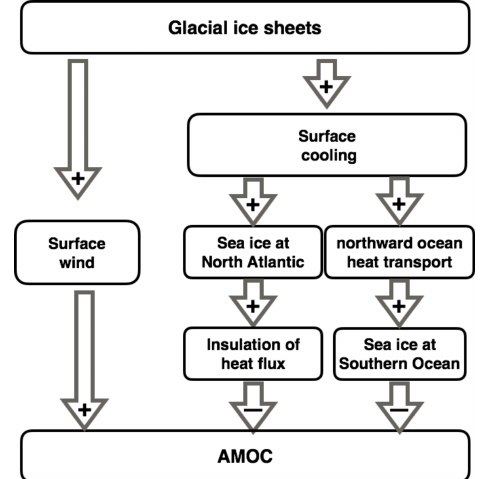
Figure 12. Simple schematic of the processes by which changes in the glacial ice sheet affect the AMOC. A stronger surface wind induced by the glacial ice sheets enhances wind-driven transport of salt into the deep-water formation region and causes a strengthen- ing of the AMOC. In contrast, a stronger surface cooling by the glacial ice sheets causes a weakening of the AMOC due to increas- ing sea ice in the North Atlantic, which insulates the atmosphere– ocean heat exchange (Oka et al., 2012). A stronger surface cooling by the northern glacial ice sheets also causes a cooling and an in- crease in sea ice over the Southern Ocean by increasing the oceanic heat transport. This change in the Southern Ocean then weakens the AMOC by increasing the density of the AABW and bottom ocean stratification (Weber et al., 2007; Klockmann et al., 2018). Possible internal feedbacks within the atmosphere–sea-ice–ocean system are discussed in Sect.